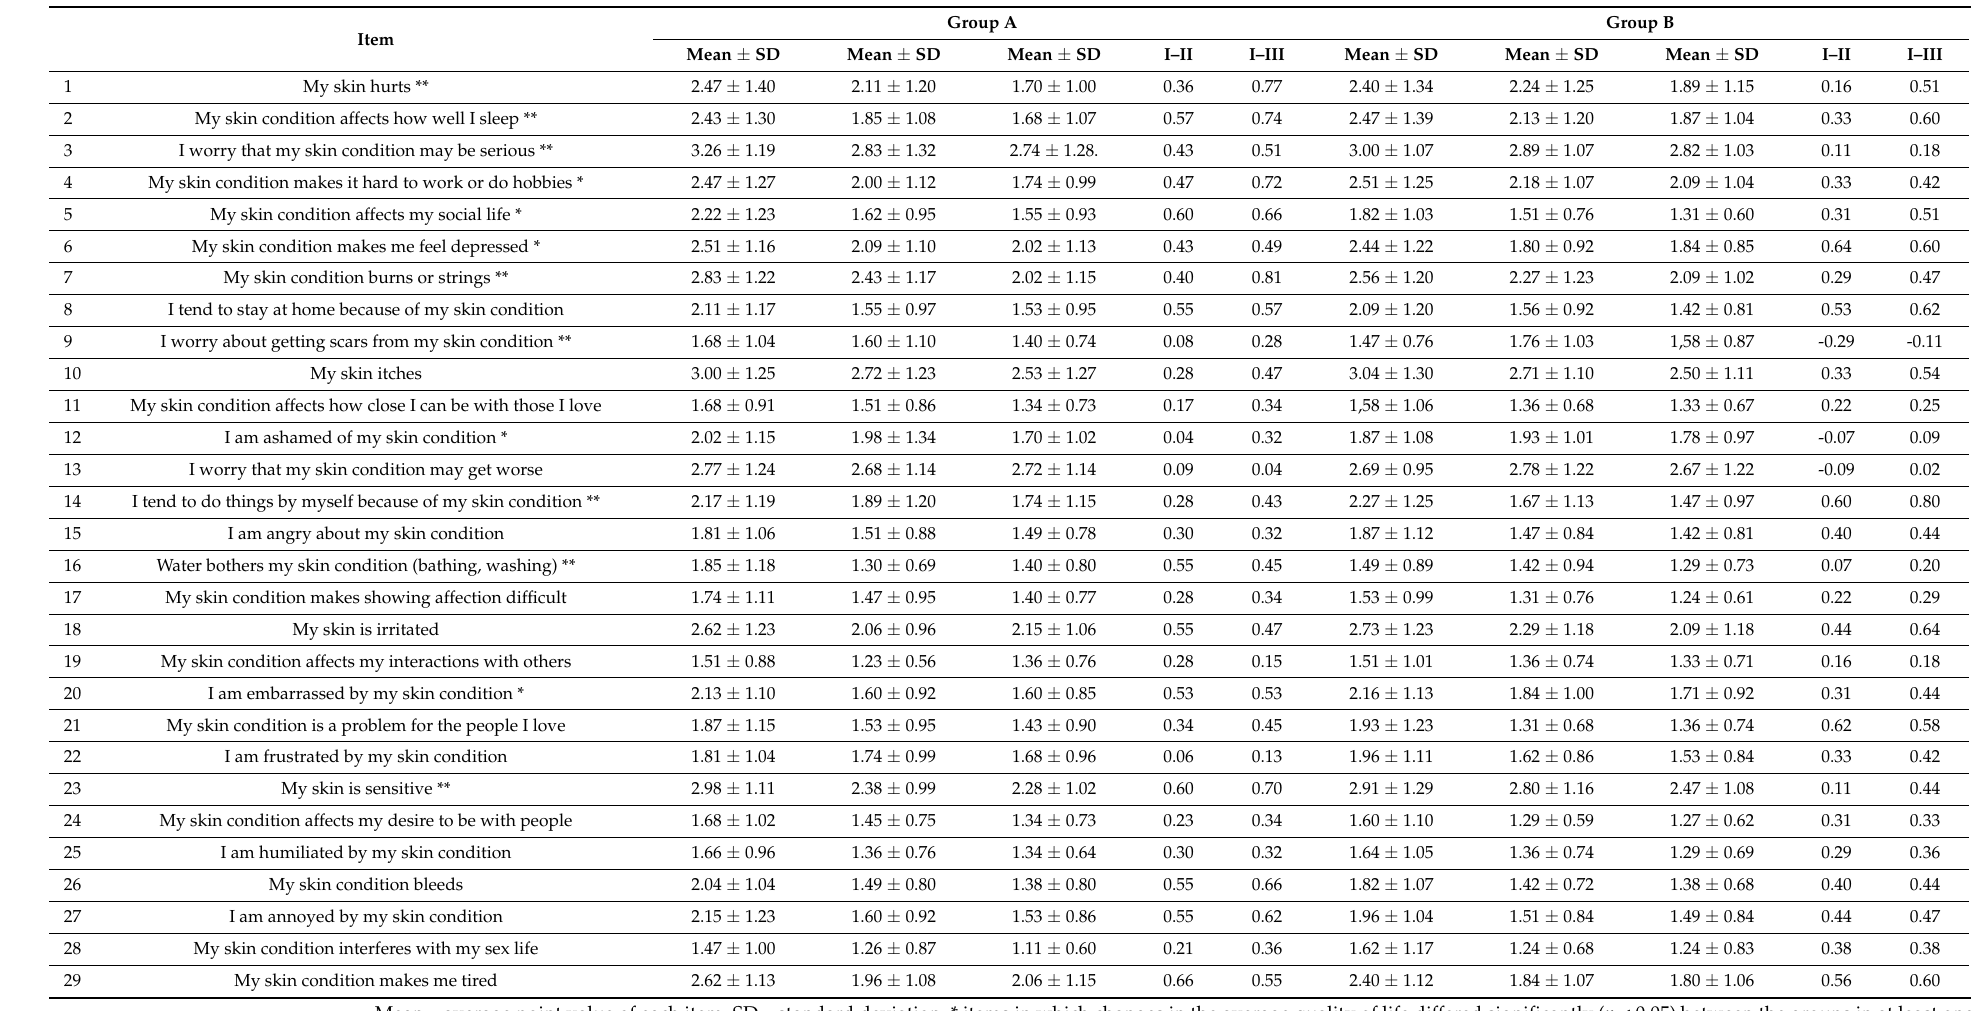
Table 3. Comparison of changes in the quality of life in individual items of the Skindex-29 scale in the studied